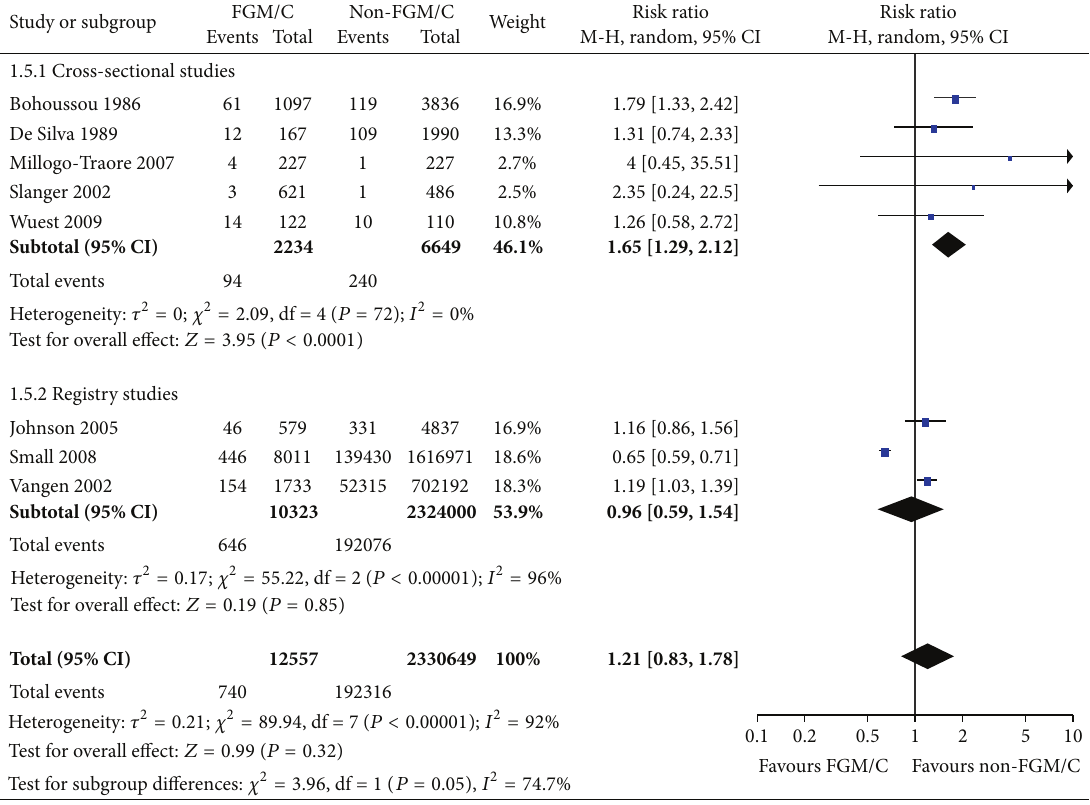
Figure 6: Forest plot, instrumental